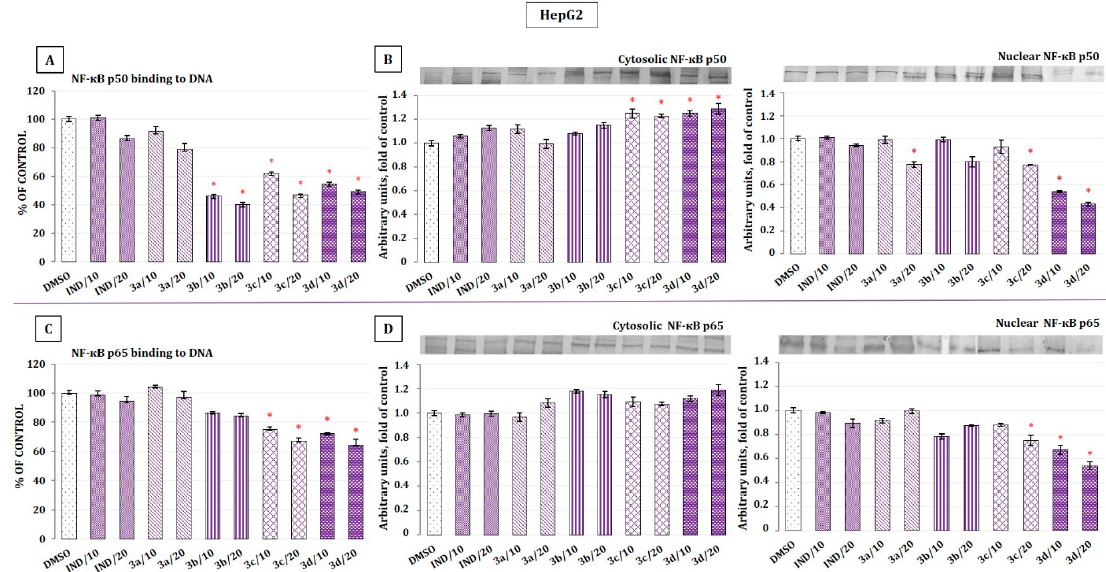
Figure 4. The effect of IND and OAO–IND derivatives ( 3a, 3b, 3c, and 3d ) on the NF- κ B p50 and NF- κ B p65 binding to DNA ( panels A,C ) and translocation from cytosol to nuclei in HepG2 cells ( panels B,D ). Activated NF- κ B p50 and NF- κ B p65 were assessed in terms of the amount of NF- κ B p50 ( panel A ) and NF- κ B p65 ( panel C ) contained in the DNA-binding complexes extracted from the nuclear fraction. The values (means ± SEM) were calculated from three sep- arate experiments as protein level in comparison with control cells (expression equals 100%). Representative immunob- lots for the analysis of the cytosolic and nuclear levels of proteins NF- κ B p50 ( panel B ) and NF- κ B p65 ( panel D ) are shown. The sequence of the bands corresponds to the sequence of the bars in the graph. The values were calculated as protein level in comparison with control cells (expression equals 1). * Significantly different from DMSO (control)-treated cells, p < 0.05. The same conjugates of IND (i.e., benzyl ester ( 3c ) and morpholide ( 3d ) derivatives) were also the most effective NF- κ B activation inhibitors in THLE-2 cells. As shown in Figure 5A,C, reduced binding levels by about 25–55% and 28–60% for p50 and p65, re- spectively, compared with the control group were found as a result of treatment with these compounds. The changes in the binding patterns of p50 and p65 subunits to their consensus side were related to their reduced translocation, particularly diminished nu-